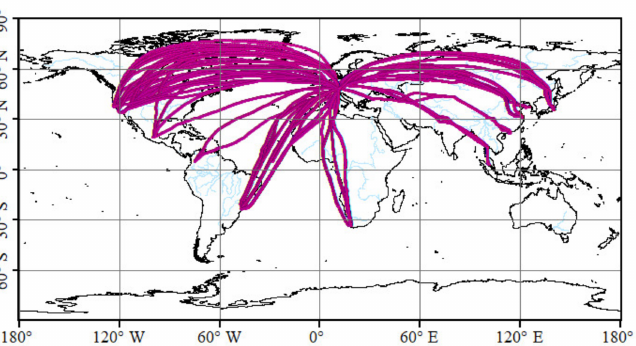
Figure 2. The flight paths of the Civil Aircraft for the Regular Investigation of the Atmosphere Based on an Instrument Container (CARIBIC) used for ozone analyses from January 2014 to